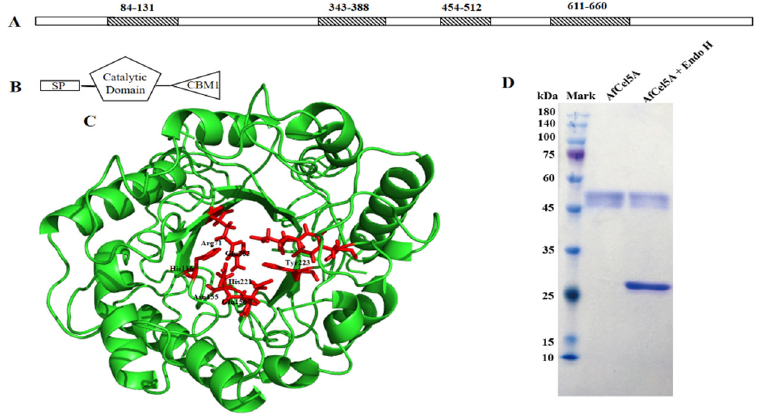
Figure 2. Structure analysis of endoglucanase AfCel5A. ( A ) The exon/intron structure analysis of gene AfCel5A. ( B ) The domain analysis of the AfCel5A protein. ( C ) Three-dimensional structure of the AfCel5A protein. ( D ) SDS-PAGE analysis of the AfCel5A protein.